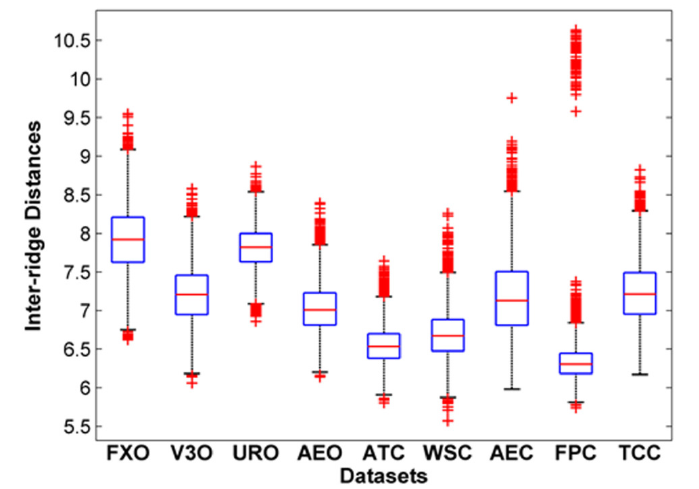
Figure 6. Box plot of inter-ridge